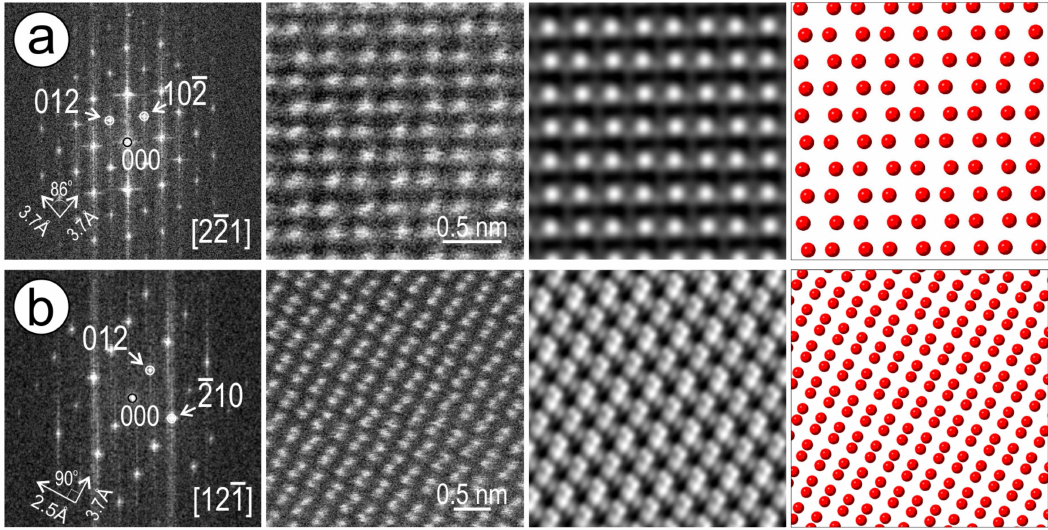
Figure 14. Assessment of atomic arrangements on HAADF STEM images obtained from hematite oriented on the two zone axes as marked. Each zone axis is represented by ( a ) and ( b ) rows, showing, from left to right: FFT, HAADF STEM image, STEM simulation and crystal structural model (space filling) of hematite. Red spheres represent Fe atoms. Indexing using crystallographic information data for hematite ( a = 5.0355 Å, c = 13.7471 Å; space group R 3 c ;